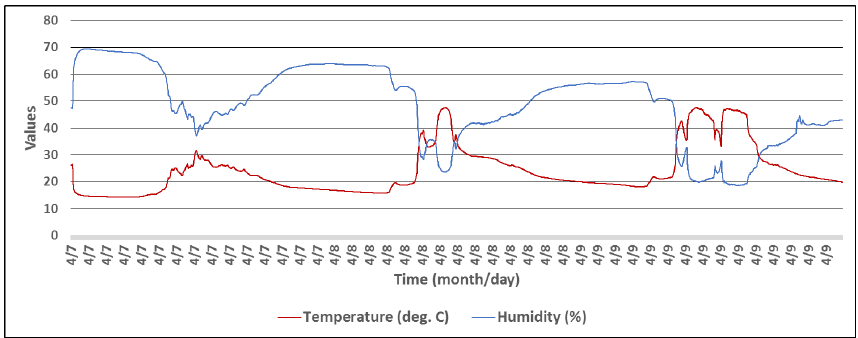
Figure 10. Temperature and relative humidity for a T, RH, and LUX beacon during three days.